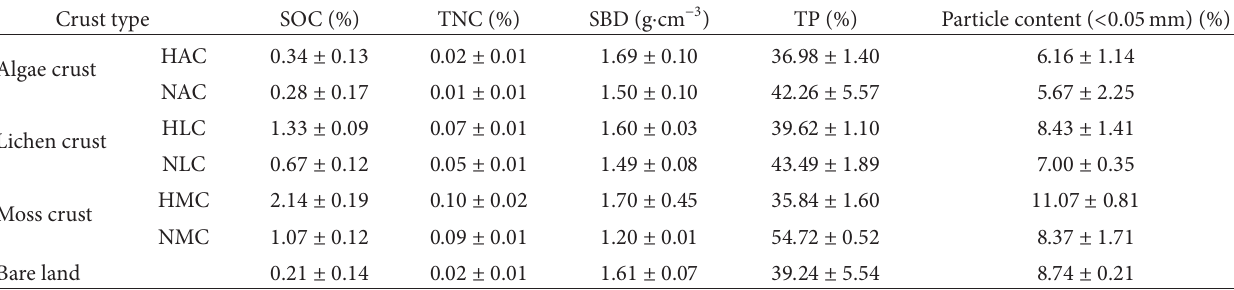
Table 1: Physical and chemical characteristics of the study sites. Values are the mean ± standard error. Crust